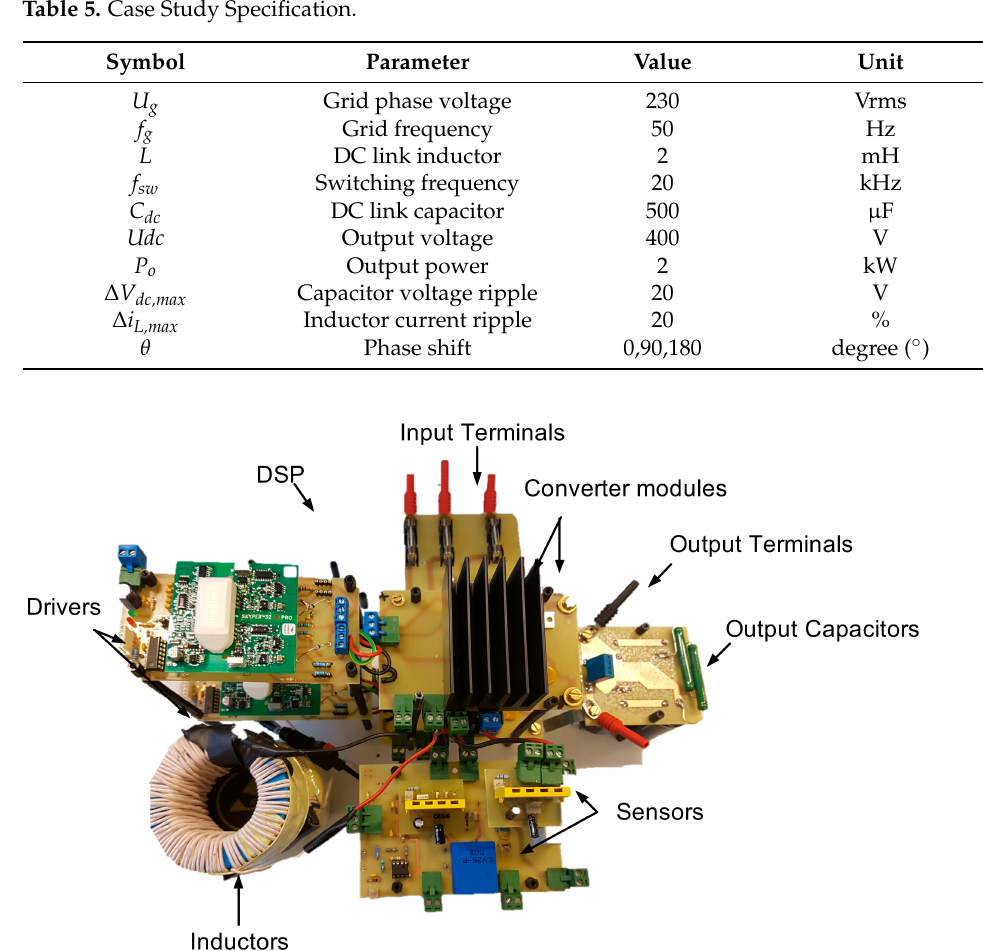
Figure 13. Experimental prototype of two single phase interleaved boost PFC